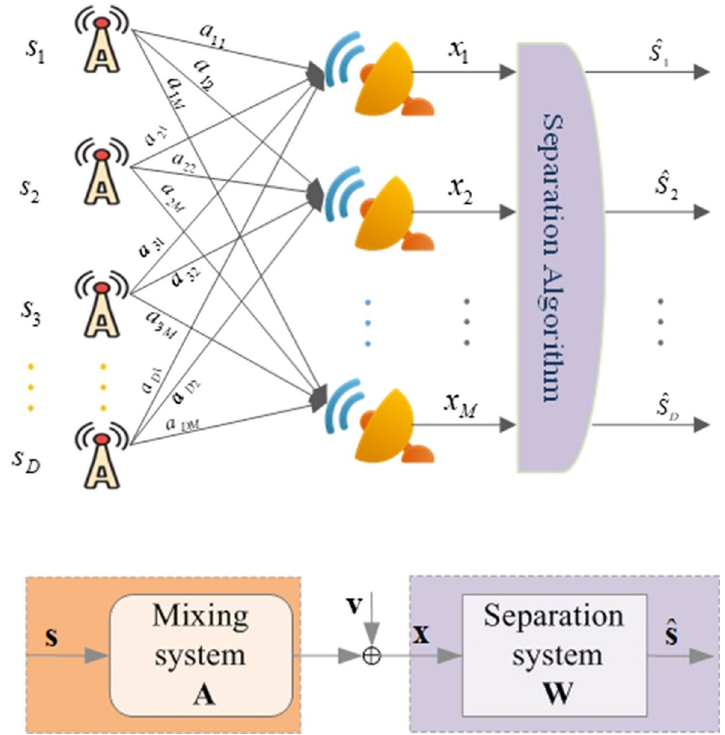
Fig. 1 Overview of signal separation